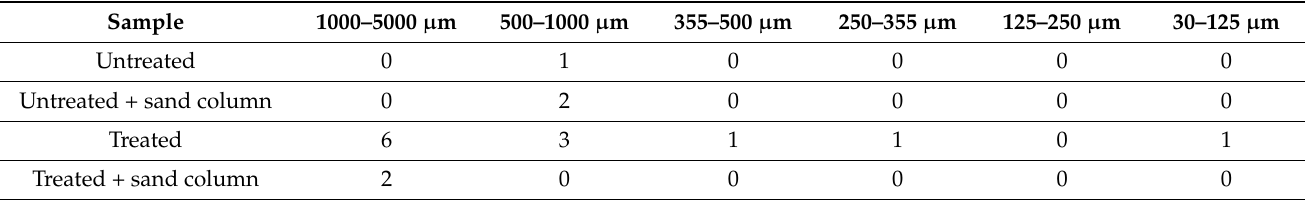
Table 2. Total number of fibers, before and after the sand-filter.